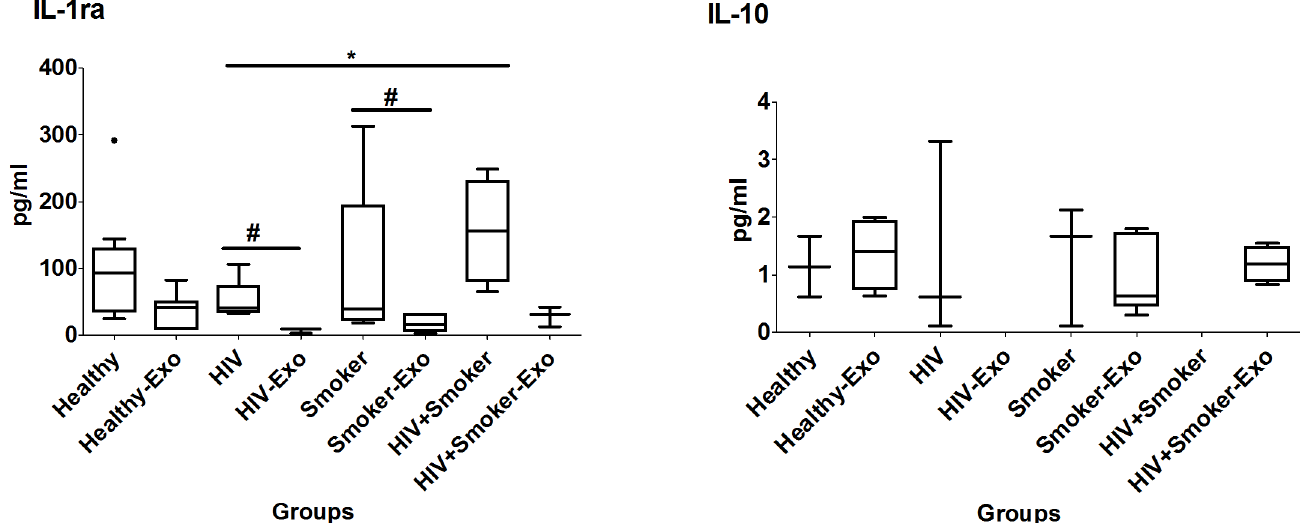
Fig 5. Box and whisker plots of anti-inflammatory cytokines between HIV-negative non-drug abusers (healthy), HIV-positive non-drug abusers (HIV), HIV-negative smokers (smokers) and HIV-positive smoker (HIV+smoker). For comparison with other study groups, the bar graphs for healthy and HIV subjects were replicated from Fig 2. The box represents the 25 th -75 th quartile, the whiskers represent the range of values, the median is presented as a line inside the box, and the out-of-range values are presented as circles. The Mann–Whitney U test was used to compare between plasma and exosomes of different study groups as well as and significant p-values are represented as # (p (cid:20) 0.05) and ## (p (cid:20) 0.01). Comparison of cytokine levels among plasma as well as exosomes of different groups were done using the Mann–Whitney U test and significant p-values are given as (cid:3) (p (cid:20) 0.05), (cid:3)(cid:3) (p (cid:20) 0.01) and $ (p (cid:20) 0.05), $ $ (p (cid:20) 0.01), respectively.